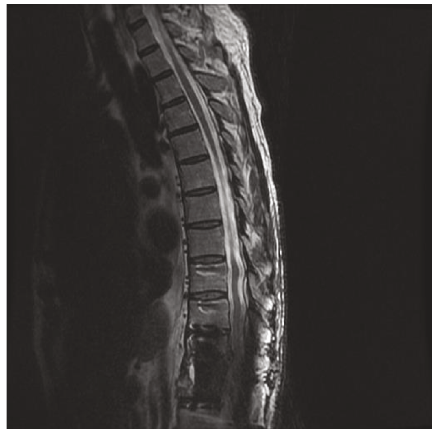
Figure 5: MR thoracic spine T2-weighted image 2 months postoperatively shows decompression of the spinal cord with